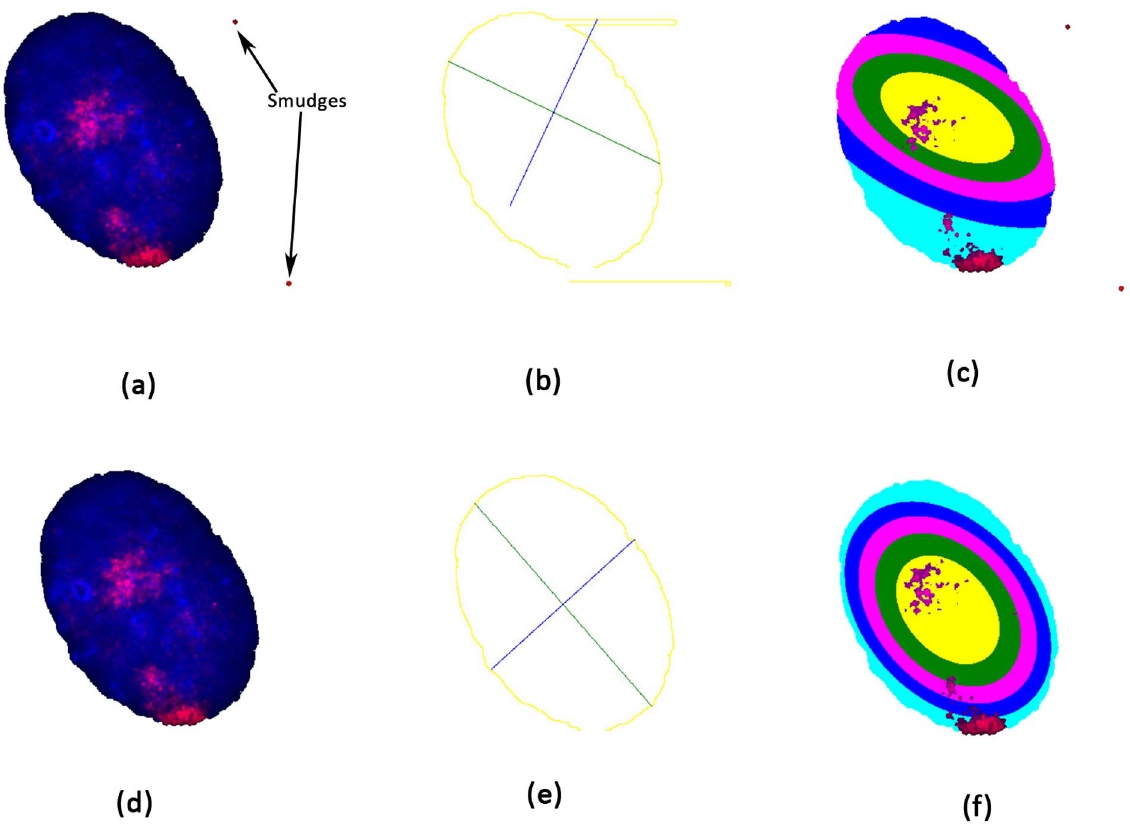
Figure 4. Steps in removing smudges outside the nucleus boundary: (a) There are a couple of unwanted smudges outside the nucleus boundary colored red. (b) These smudges pose a problem while computing the contour, which assumes the presence of any color other than background color (white) as the beginning of the nucleus. The major and minor axes can be seen to be erroneous. (c) Consequently, the partitioning of the nucleus is incorrect too. (d) The pre-processing step removes the smudges. See Methods section for the detailed algorithm. (e) The computation of the contour, the major and the minor axis are now correct. (f) The erroneous partitioning is thus fixed.